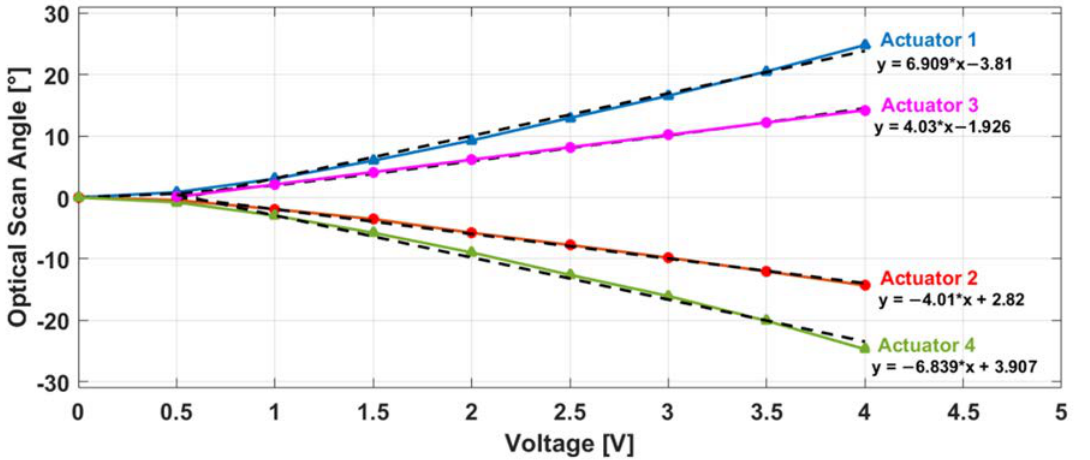
Figure 5. Optical scan angle variation with the driving voltage for the four actuators with the curve fitting equation of each one (black curves).